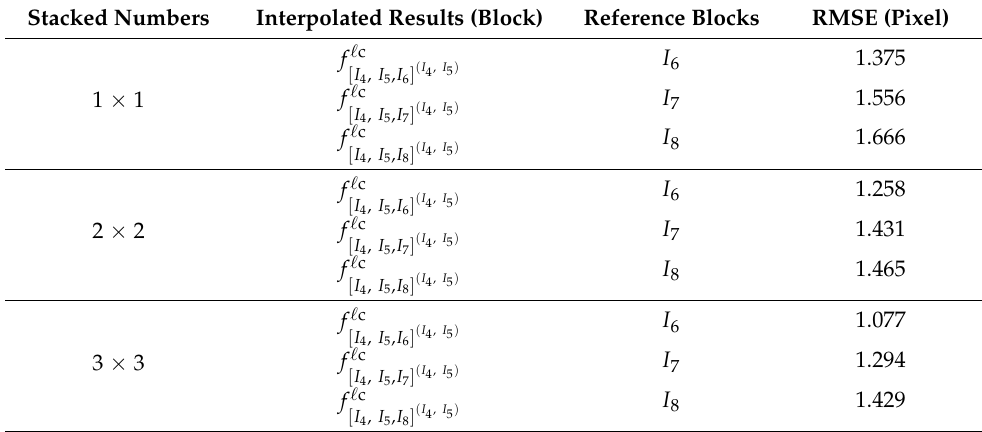
Table 6. Quantitative evaluation between block interpolated result and reference block using different stacked convolution